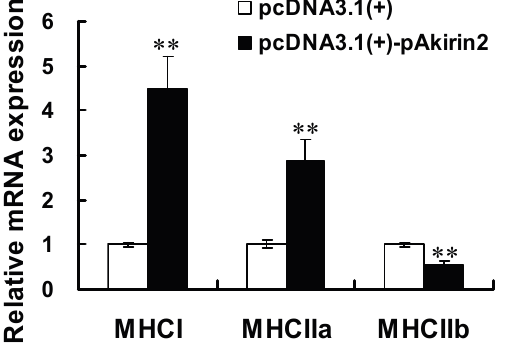
Figure 3. Effect of pAkirin2 on MHC isoform expression in C2C12 myotubes. C2C12 myoblasts were cultured and transfected as in Figure 2. Two days after the transfection, the mRNA levels of MHCI , MHCIIa and MHCIIb were determined using real-time quantitative PCR. Samples were performed in duplicate. The amount of MHCI , MHCIIa and MHCIIb mRNA were normalized to the amount of GAPDH mRNA and m β -actin mRNA. Data were presented as means ± SE ( n = 3). ** p <